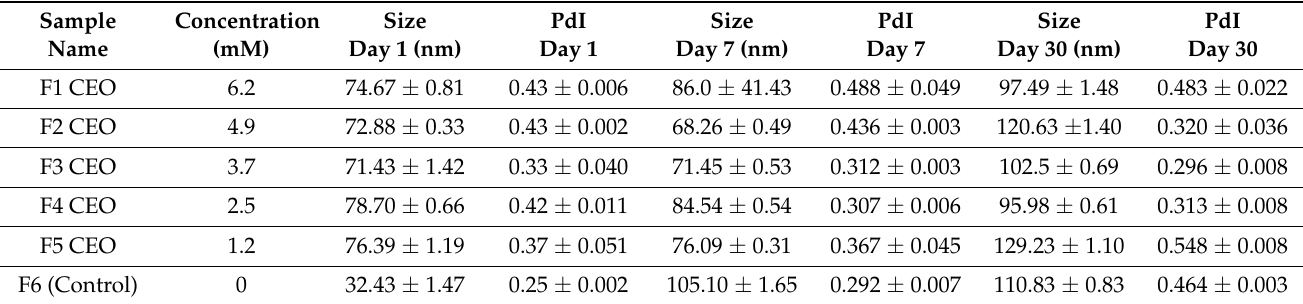
Table 1. The particle size distribution and PdI of CEO-loaded nanoliposomes (F1 to F5 fractions) and control sample (F6 fraction) after day 1, 7, and 30 of storage at 4 ◦ C . Data were articulated as mean values ± standard